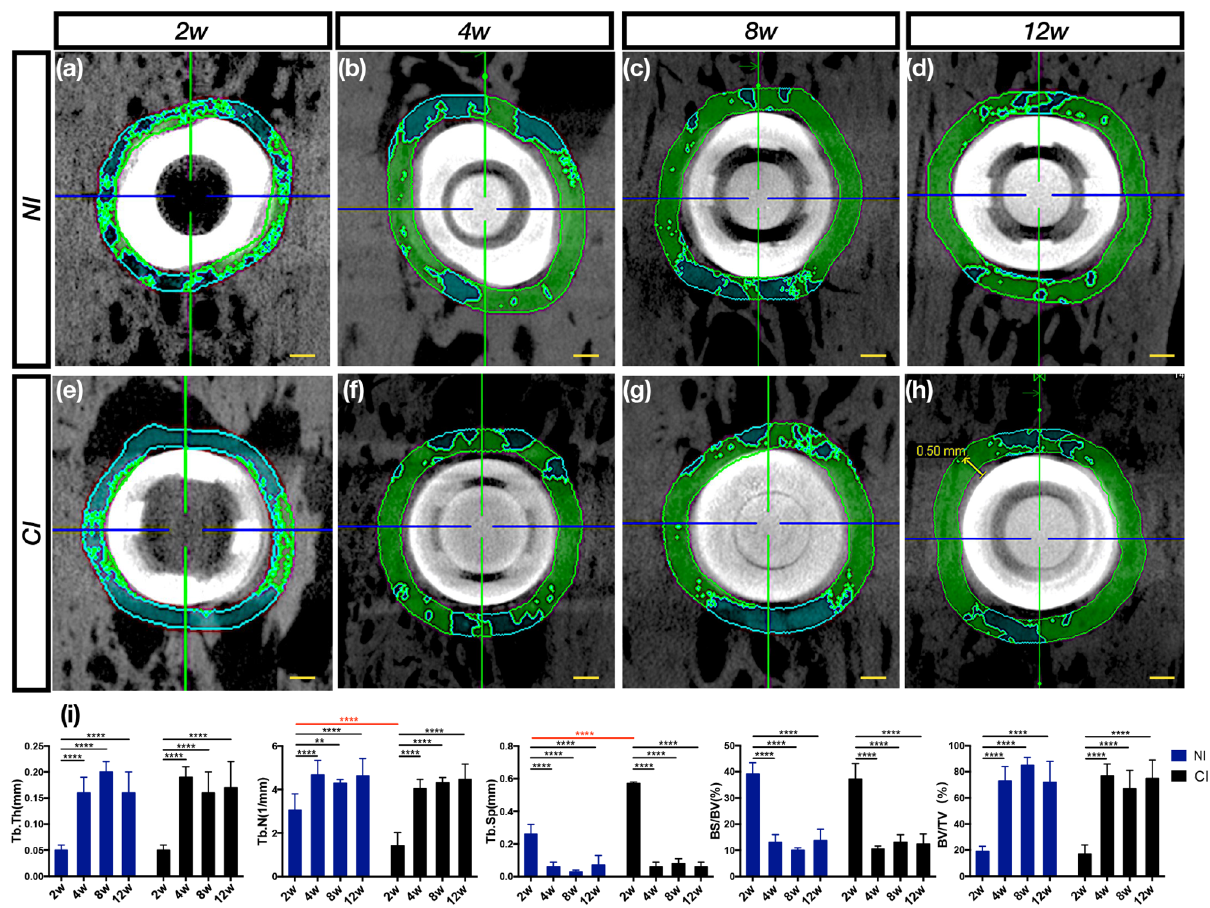
Figure 1. Osseointegration within a 0.5 mm cross-section from the surface and along the long axis top to 2 mm was measured through micro-CT. ( a , e ) The number of bone trabeculae around the two implants was low, indicating that the bone remodeling process was active and that there were fewer bone trabeculae in the CI than in the NI, suggesting that the surface of the treated CI was more active. ( b – d , f – h ) From the 4th to 12th weeks, the number of bone trabeculae in the two implants increased and stabilized. ( i ) Micro-CT evaluation of trabecular regions selected around the implant after 12 weeks of osseointegration. From the time of vertical perspective, osseointegration of the two implants was promoted from the 2nd to 4th weeks in terms of the Tb.Th, Tb.N, Tb.Sp, BS/BV and BV/TV. From the time of transverse perspective, bone modeling in the CI was more active than that in the NI in terms of the Tb.N and Tb.Sp at the 2nd week, but there were no differences at other times. Scale bars represent 0.5